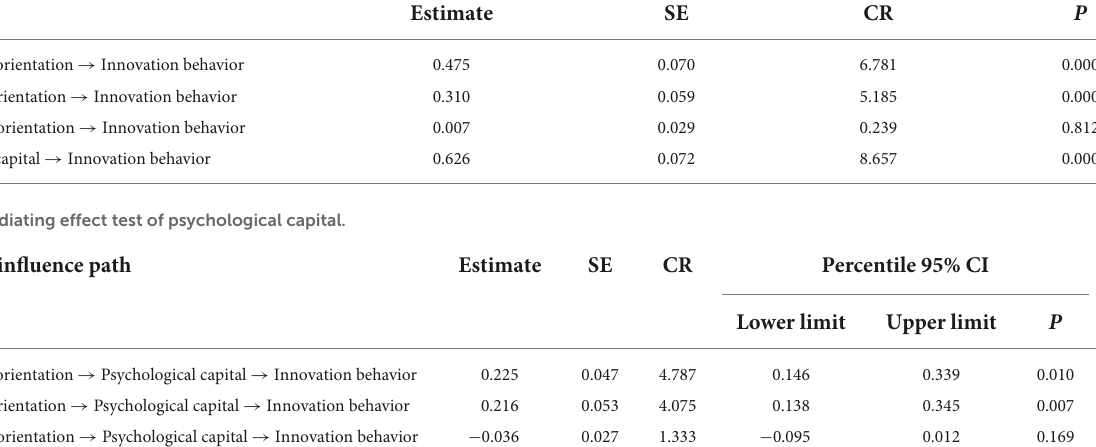
TABLE 4 Results of the influence of goal orientation, psychological capital on innovation behavior. Path